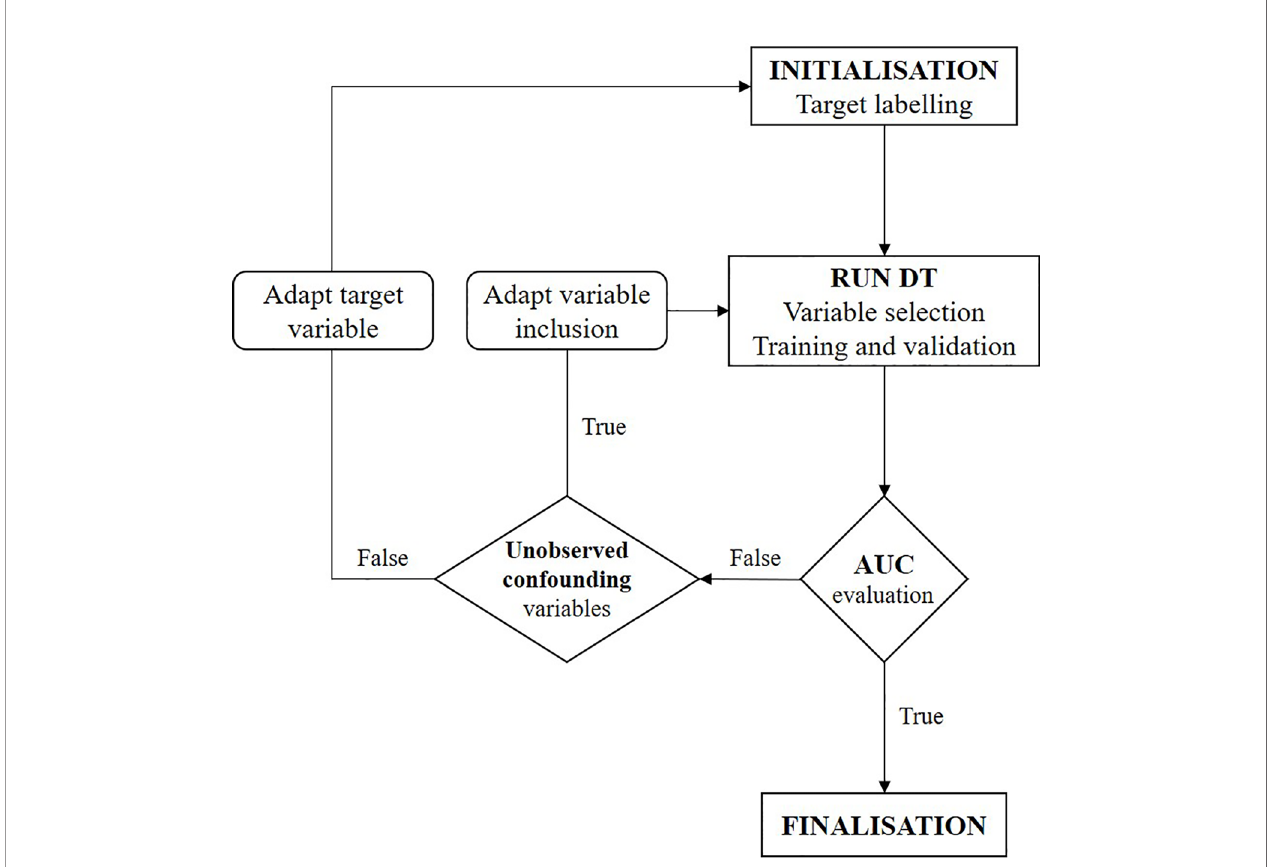
FIGURE 1 | Flowchart of two-step iterative exploratory learning process. The model is iterated until the area under the receiver operating characteristic curve (AUC) is satisfactory, i.e. until the highest achievable AUC in practice is found. Unobserved confounding variables are (unknown) variables currently not captured in real- world situations. (AUC, area under the receiver operating characteristic curve; CT, decision